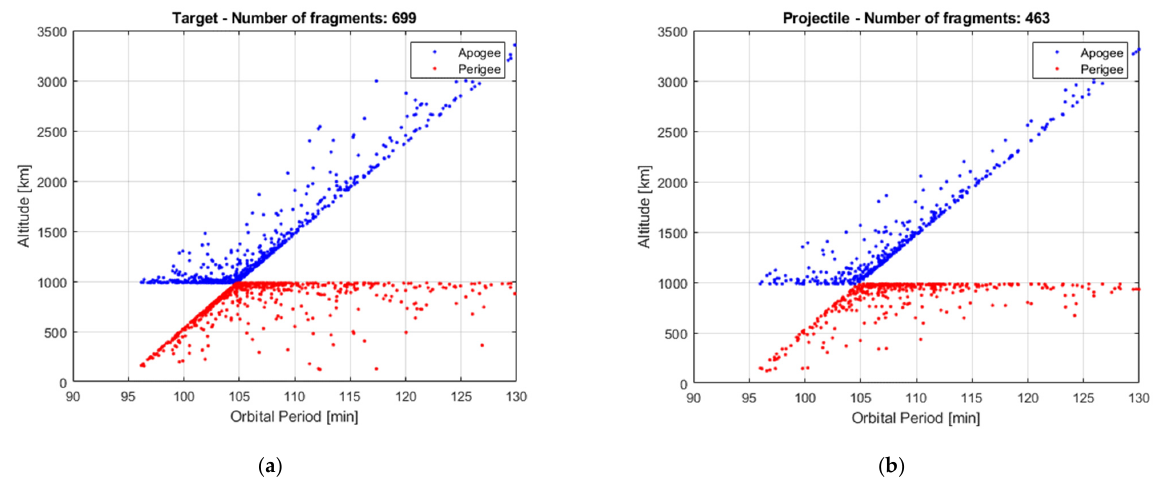
Figure 11. Gabbard diagrams for the target ( a ) and the projectile ( b ), obtained with fragmented masses estimated by iterative approach for first test case.